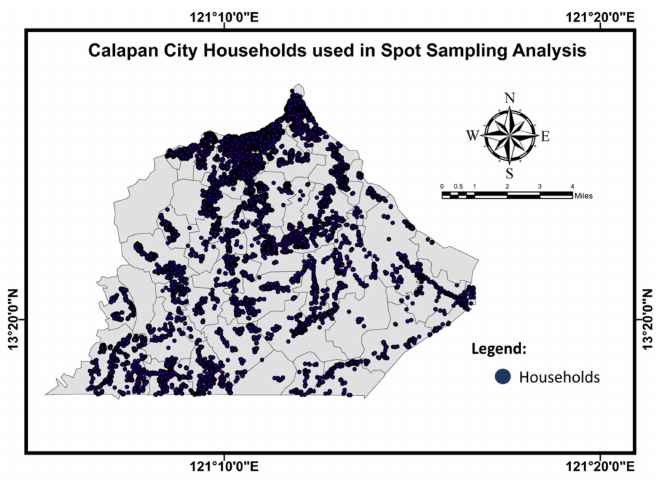
Figure 12. Concentration of Zn in GW samples.